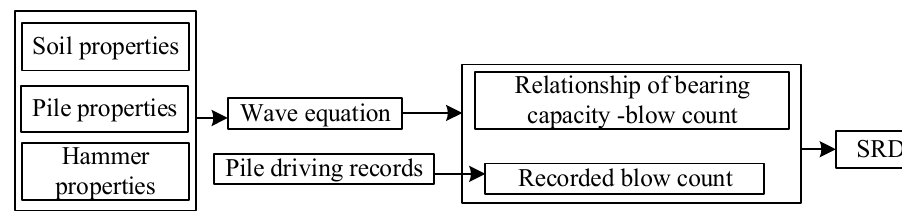
Figure 1. The flow chart of the back analysis.